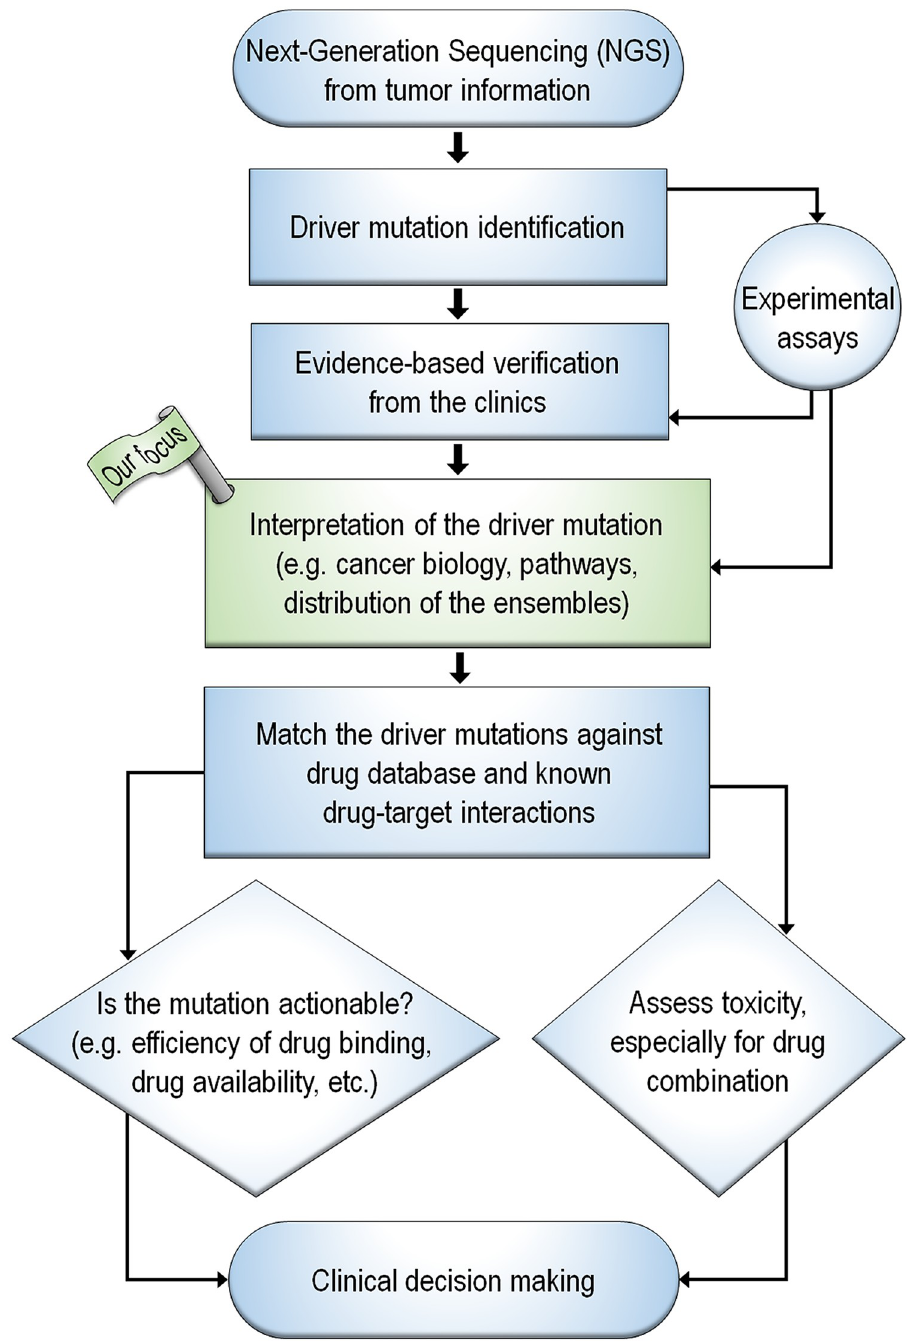
Fig 3. A flowchart representing the comprehensive framework to precision oncology. Here, our focus is the process of the interpretation of the driver mutation using the databases in cancer biology, cancer pathways, and the distribution of the ensembles of protein conformation. The next process to match the driver mutations against drug databases and known drug-target interactions is not discussed in this paper.